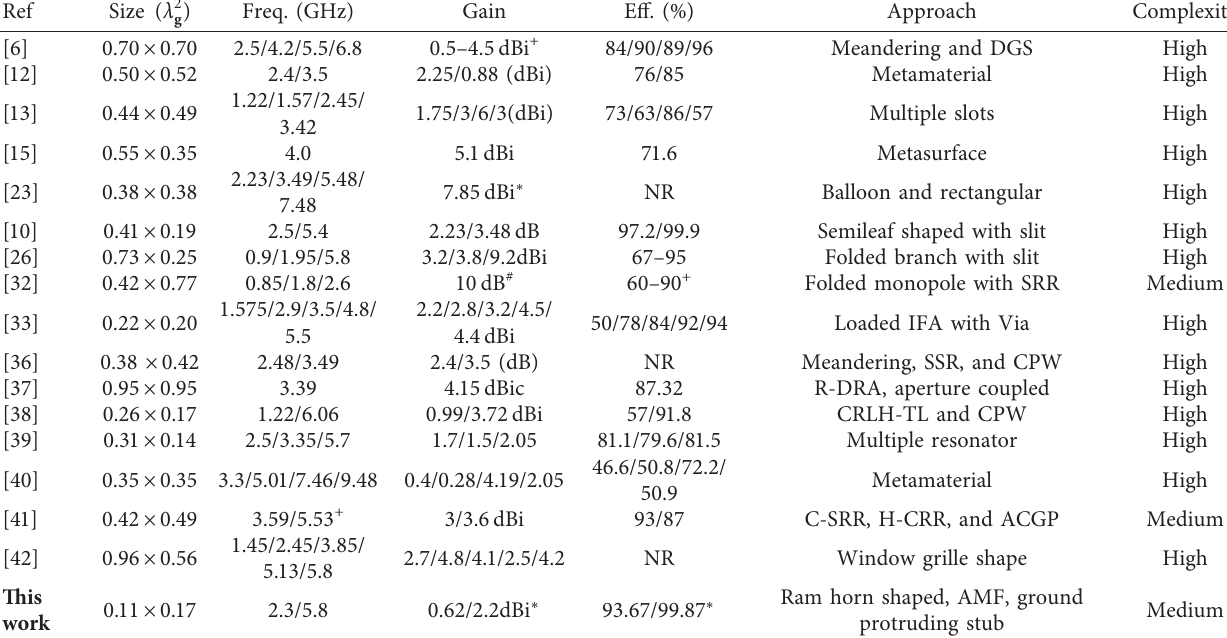
Table 2: Comparison of the ram horn-like folded antenna with recent